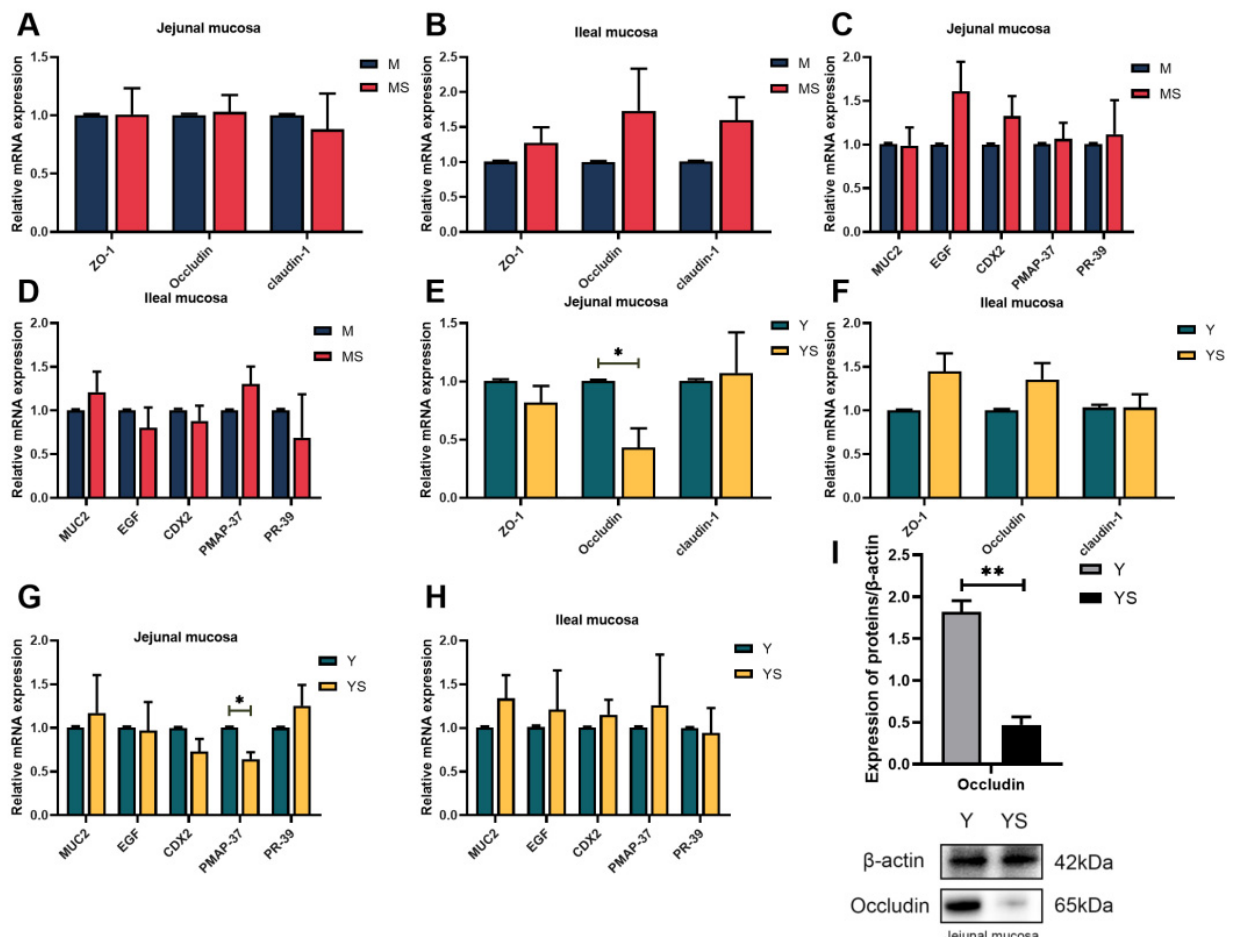
Figure 2. Effects of chronic cold stress on intestinal growth and development of pigs. ( A , B ) The mRNA expression levels of tight junction proteins in the intestinal mucosa of Min pigs (n = 6). ( C , D ) The mRNA expression levels of developmental function-related genes in the intestinal mucosa of Min pigs (n = 6). ( E , F ) The mRNA expression levels of tight-junction proteins in the intestinal mucosa of Yorkshire pigs (n = 6). ( G , H ) The mRNA expression levels of developmental function-related genes in the intestinal mucosa of Yorkshire pigs (n = 6). ( I ) The protein expression level of Occludin in the jejunal mucosa of Yorkshire pigs (n = 6). Data are presented as the means ± SEM. * p < 0.05, ** p < 0.01.